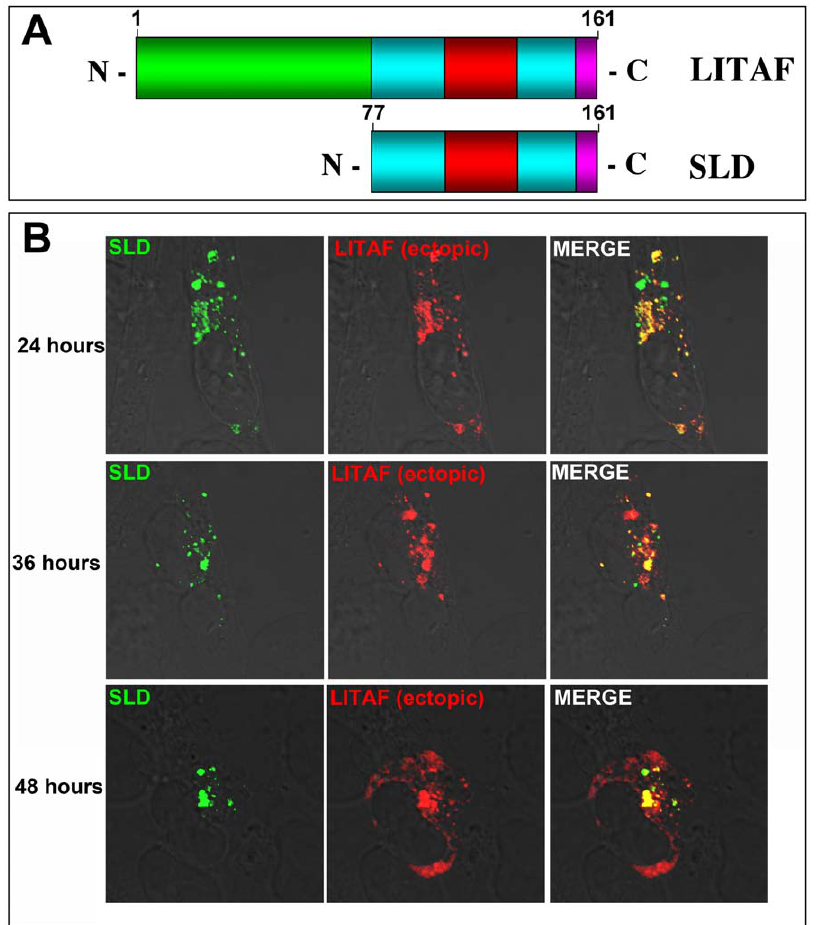
Figure 3. Over-expression of the SLD results in perinuclear localization. (A) Schematic of full-length LITAF and the SLD showing the proline rich N-terminus of LITAF (green) and the SLD is composed of a RING finger-like domain (cyan) which is interrupted with a hydrophobic domain (red). (B) BGMK cells were transiently co-transfected with FLAG-LITAF and myc-SLD. Twenty-four, 36, and 48 hours after transfection, cells were fixed and underwent indirect immunofluorescence. FLAG-LITAF was detected using an anti-FLAG antibody (red) and myc-SLD was detected using anti-myc antibodies (green). Yellow shows regions where the two proteins co-localize.